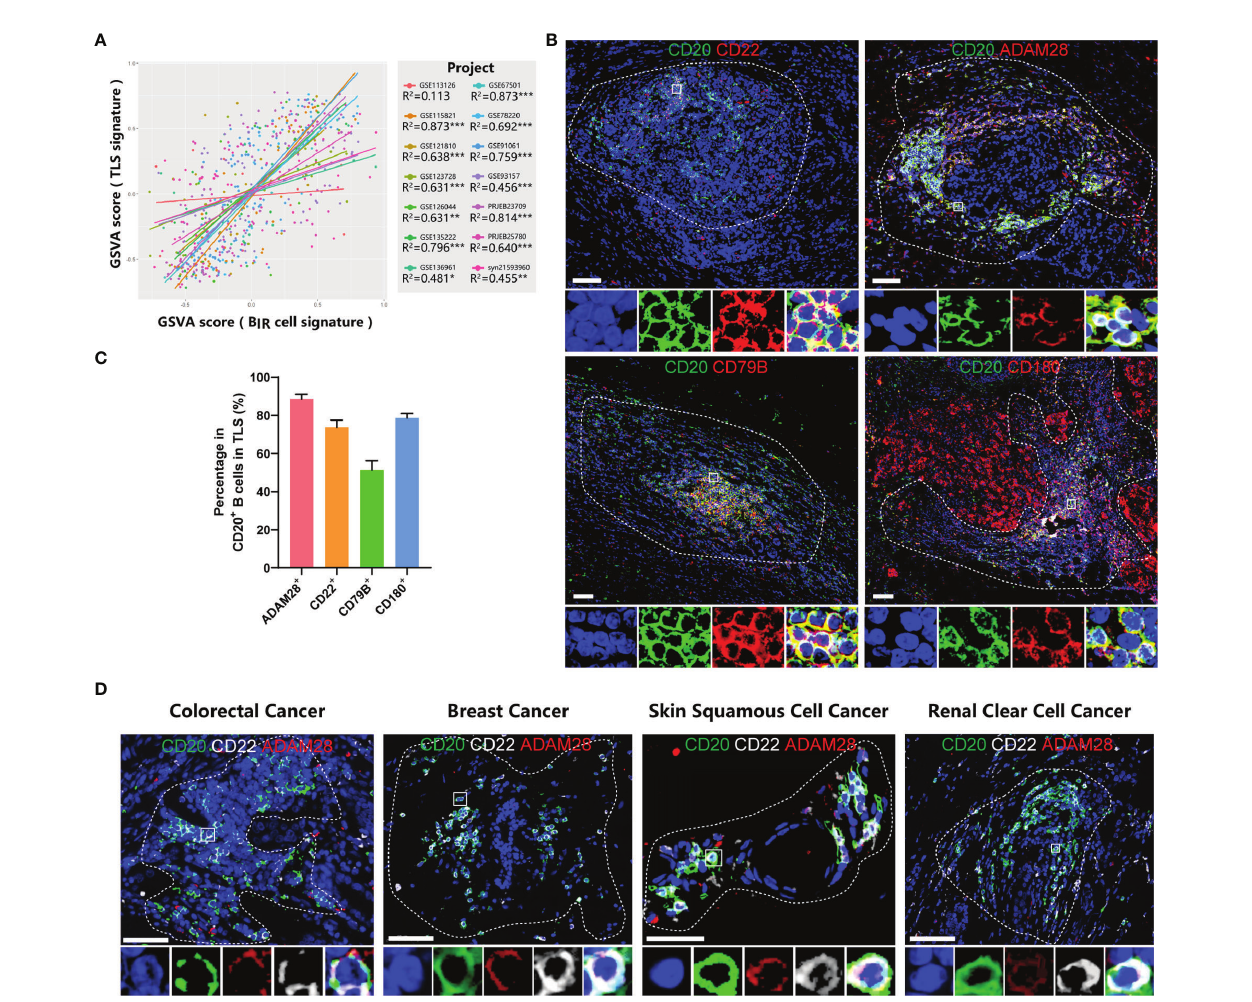
FIGURE 6 | B IR cells accumulate in TLSs. (A) Linear regression analysis between GSVA scores of B IR cells signatures and TLSs. Samples (dots) wi th a higher GSVA score indicate a higher degree of enrichment of this signature. Samples (dots) and trendlines (lines) in different data sets are drawn with different colors. Correlation coef fi cient are presented as R2. *P < 0.05; **P < 0.01; ***P < 0.001. (B) Immuno fl uorescence staining of B IR cells in breast cancer for CD20 (green) and the indicated markers (red), including ADAM28, CD22 , CD79B, and CD180. (C) Percentage of posi tive cells for these marker in CD20+ B cells in TLSs. (D) Characterization of B IR cells for CD20 (green),CD22 (white), and ADAM28 (red) in colorectal cancer, breast cancer, skin squamous cell cancer and renal clear cell cancer. (B, D) The area of TLS is indicated by white dashed l ines based on related immuno fl uorescence staining for TLS in supplementary fi gure 7. The multispectral image of B IR cells in the white rectangle is displayed below the original picture.All DAPI staining is shown in blue.Scale bar=